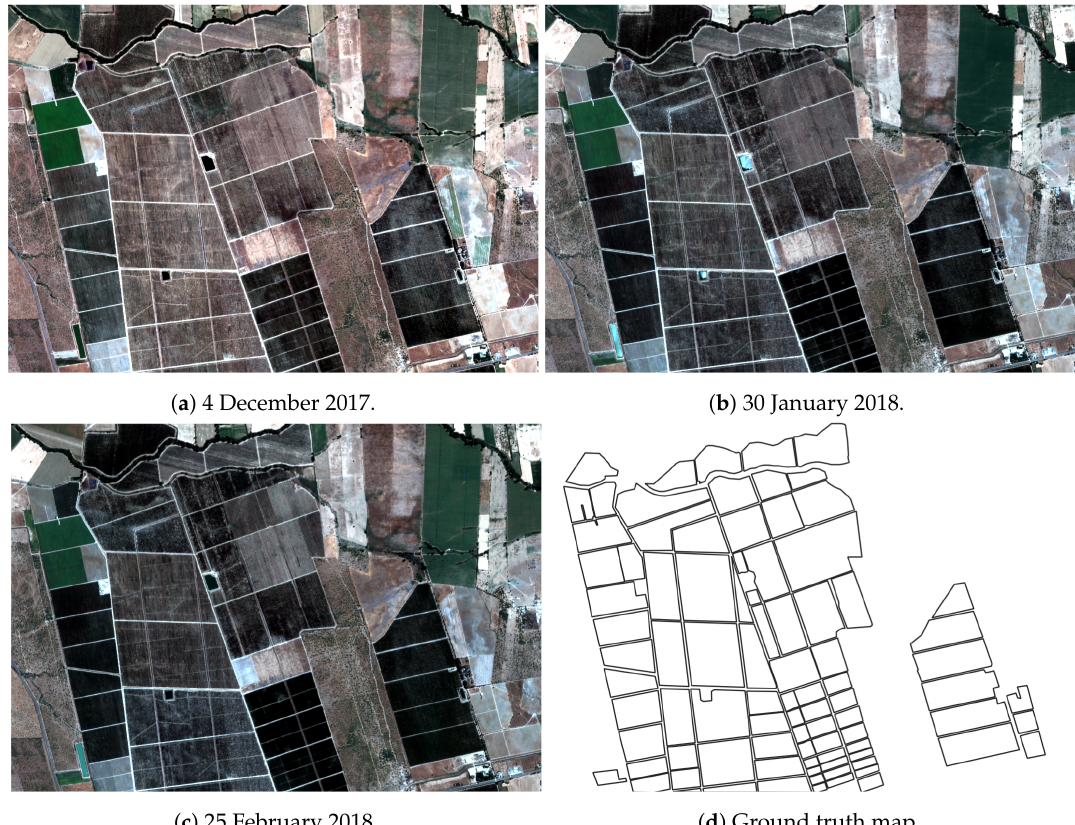
Figure 2. Color compositions (3-2-1) of the Plèiades-1 imagery for three different dates and the ground truth of the study